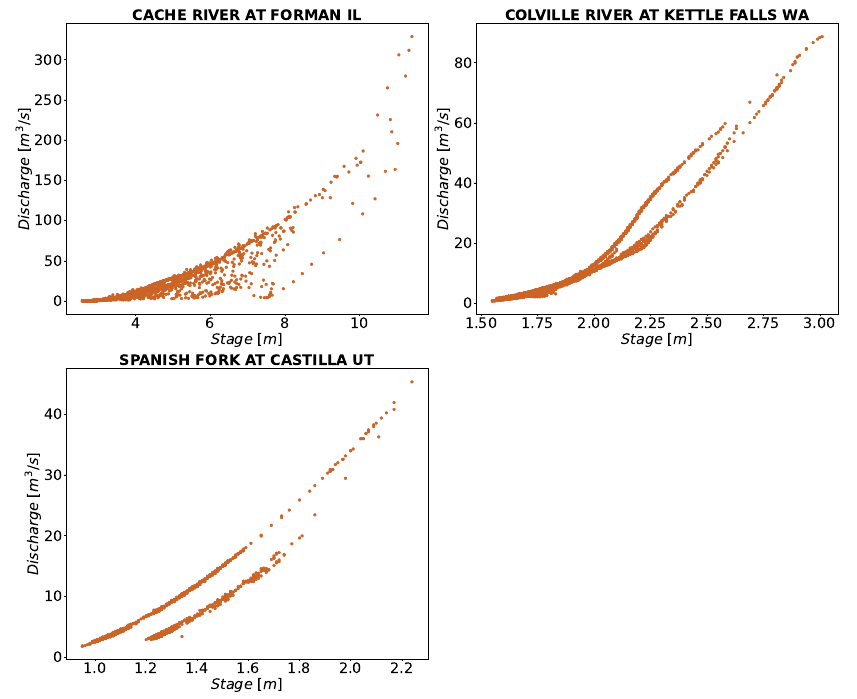
Figure 8. The plot of the stage-discharge measurements depicts different rating curve for the stations in the